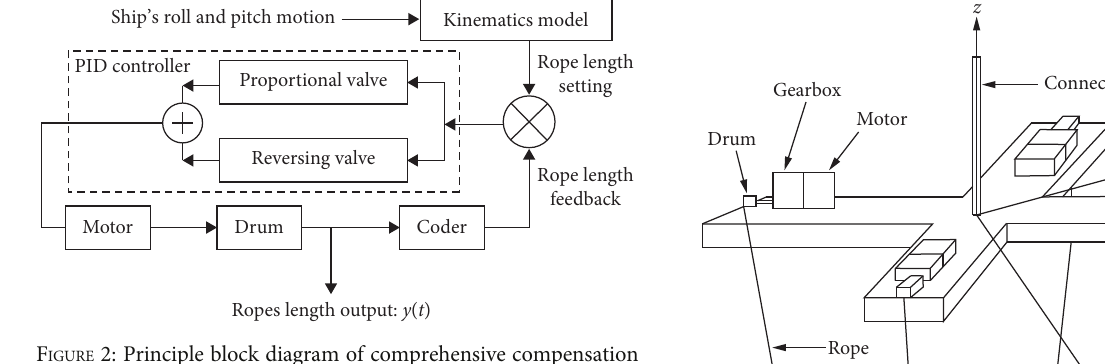
F IGURE 2: Principle block diagram of comprehensive compensation system.